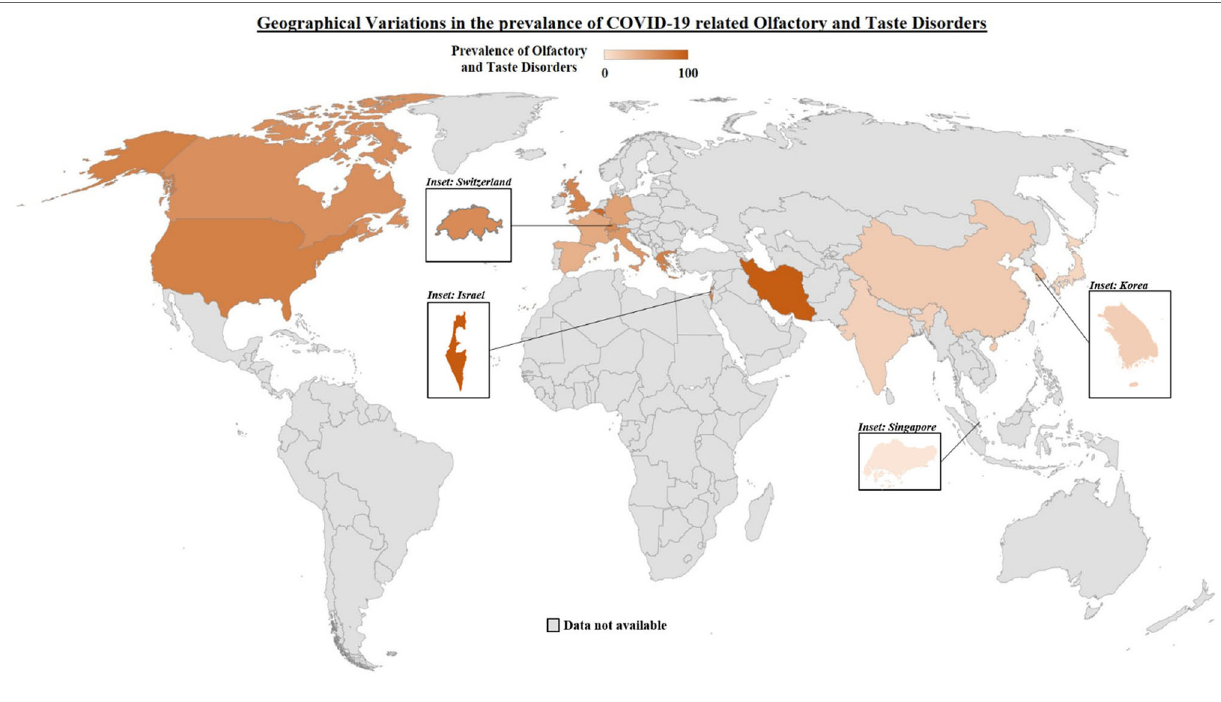
TABLE 1 | Geographical and testing